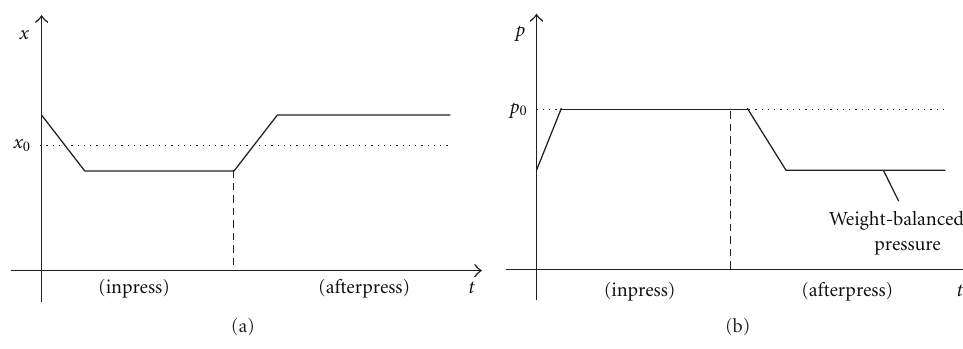
Figure 8: Illustration of the compliance during forging steps.